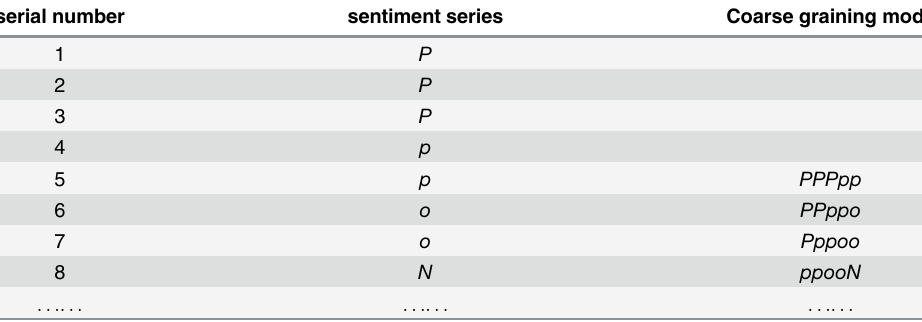
Table 3. Coarse graining processing of sentiment